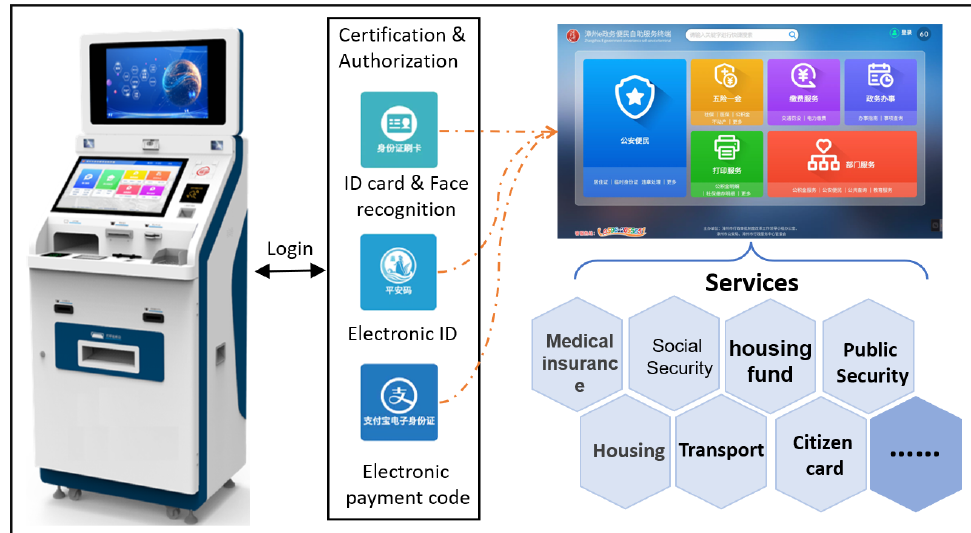
Figure 4. The running interfaces of system (This system is developed for the Zhangzhou Municipal